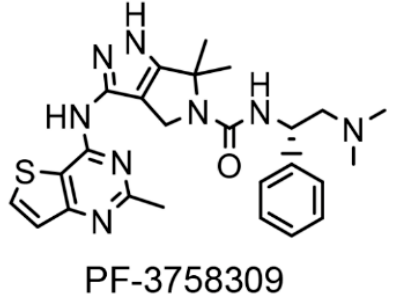
Figure 1. Chemical structure of PF-3758309.